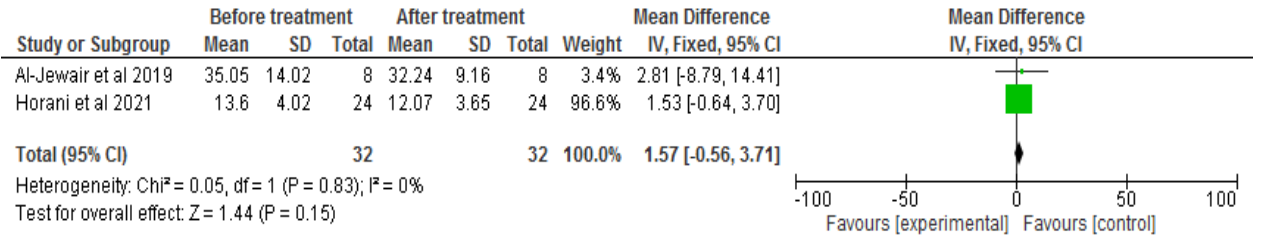
Figure 4. Forest plot for clear aligner between before and after treatment.